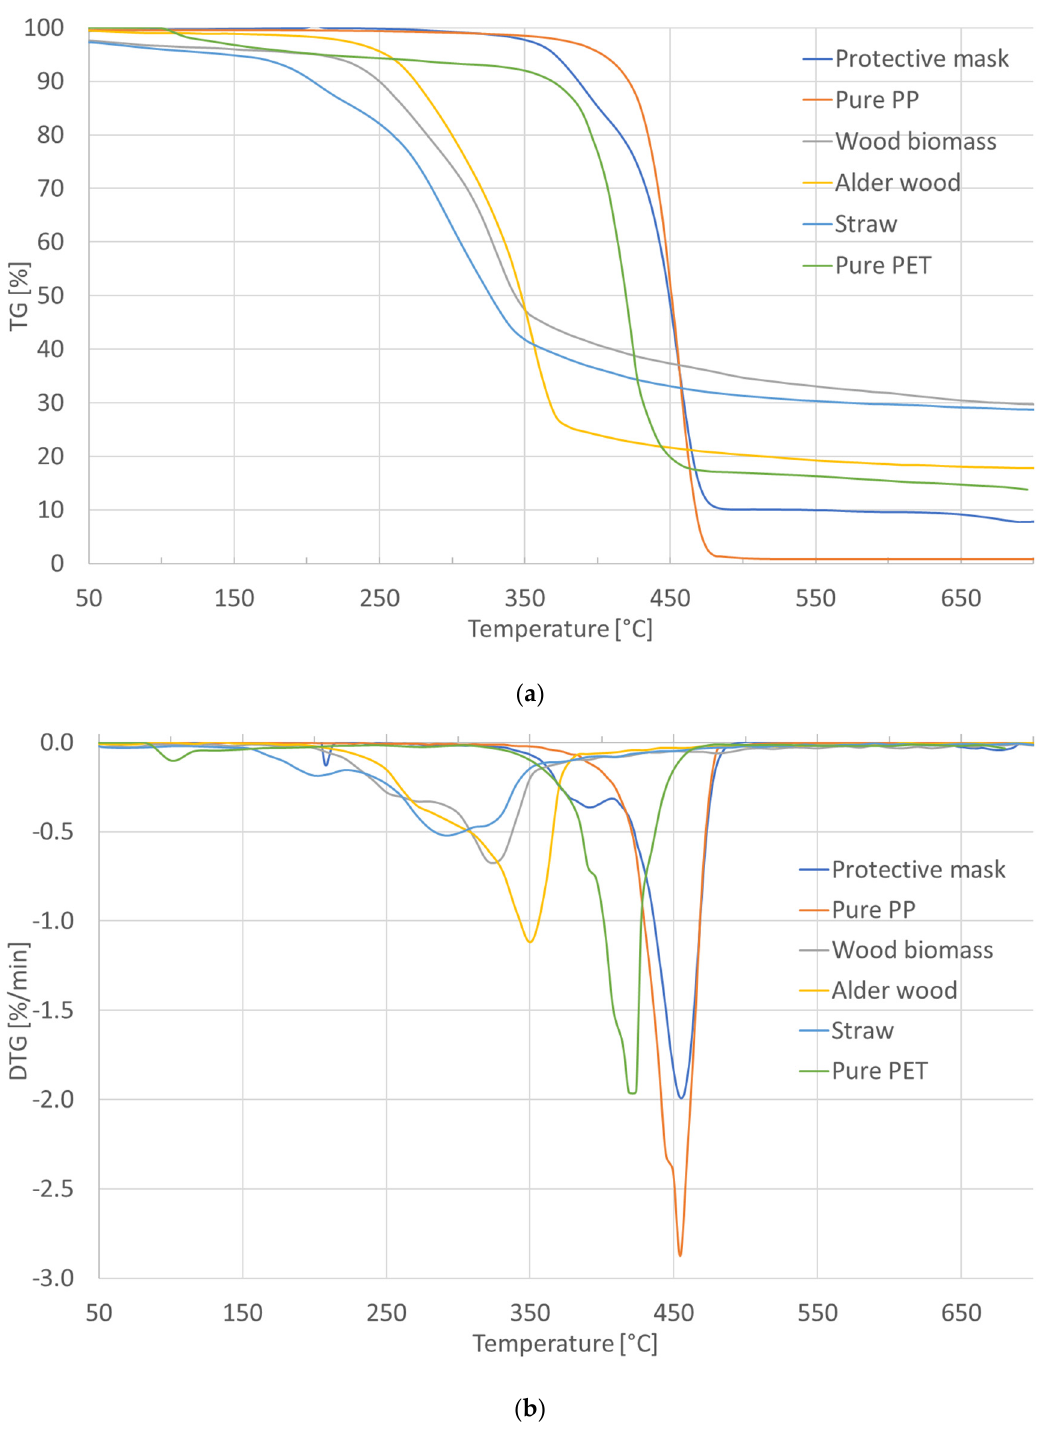
Figure 5. Comparison of repeated TG curves ( a ) and the TG and DTG curve ( b ).